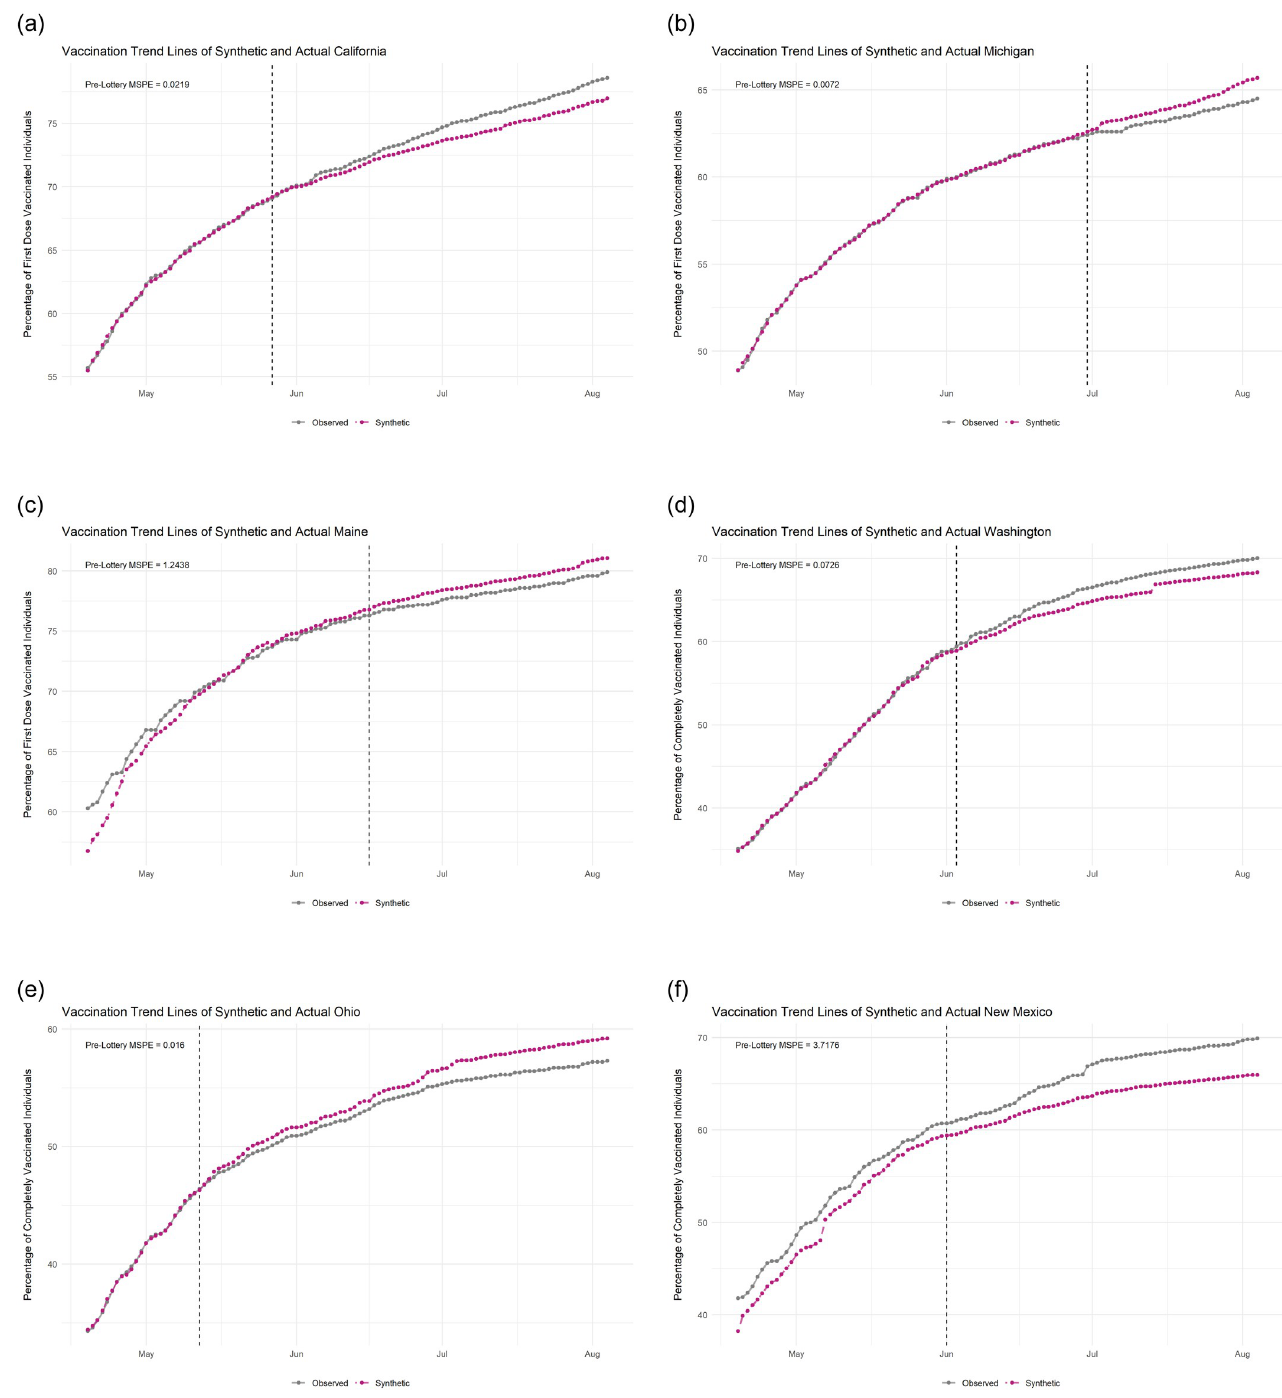
Fig 2. Selected observed and synthetic vaccination rate trend lines by state. A: California (May 27th) B: Michigan (June 30th) C: Maine (June 16th) D: Washington (June 3rd) E: Ohio (May 12th) F: New Mexico (June 1st).